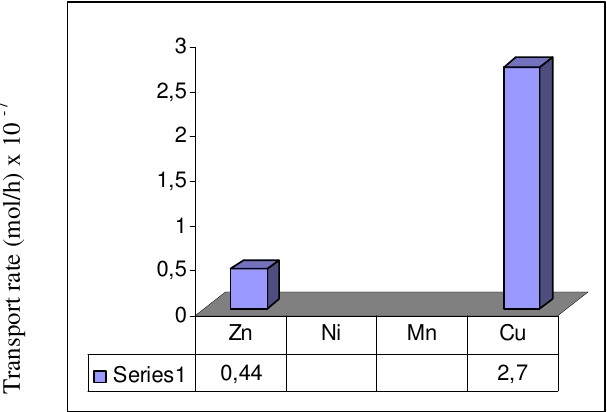
Figure 4. The competitive transport rates for the MTTT.